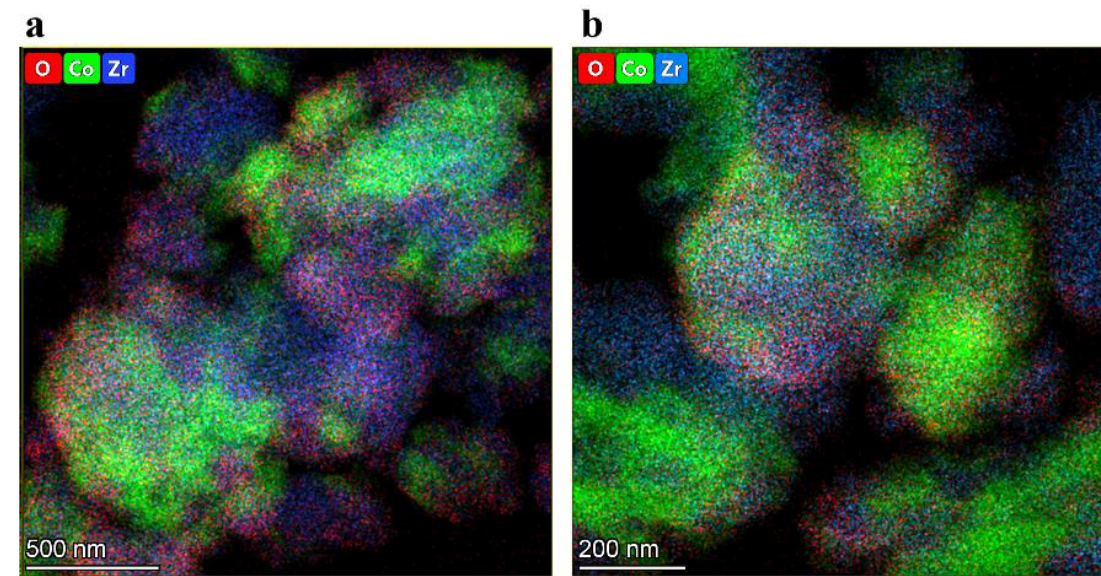
Figure 6. Typical EDX mapping of the Co-Zr product: ( a ) after mechanical alloying; ( b ) after mechanical alloying and hydrogen treatment.